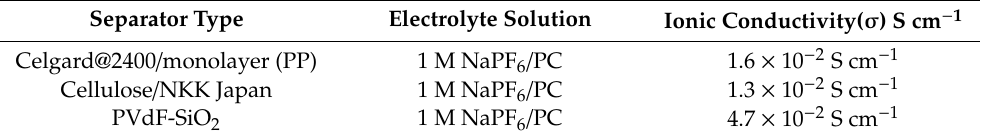
Figure 5. ( a ) Charge–discharge plot of P2-Na 0.66 Fe 0.5 Mn 0.5 O 2 cathode vs. sodium metal anode using PVdF-SiO 2 separator membrane between 2 and 4 V at 0.1 C rate. ( b ) Cyclic voltammetry of P2- Na 0.66 Fe 0.5 Mn 0.5 O 2 using PVdF-SiO 2 separator membrane.